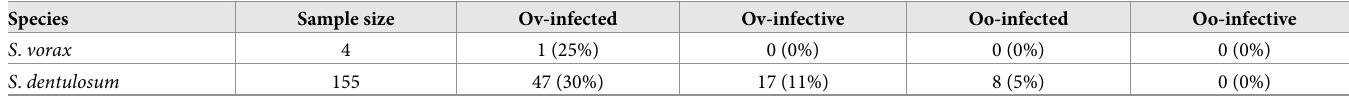
Table 4. Infection and infectivity rates for O . volvulus and O . ochengi amongst anthropophilic blackflies within the Kakoi-Koda focus. Species Sample